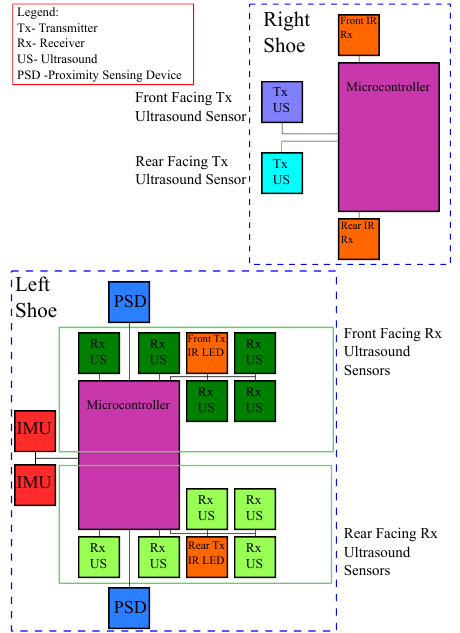
Figure 2. Block diagram of the inertial measurement unit and ultrasound sensors (IMU/US) system setup. The infrared (IR) LEDs are used to synchronise the ultrasound transmitters and ultrasound receivers. The sensors are connected to an ATMega328P micro-controller, which relays the information to a desktop PC for data-processing.